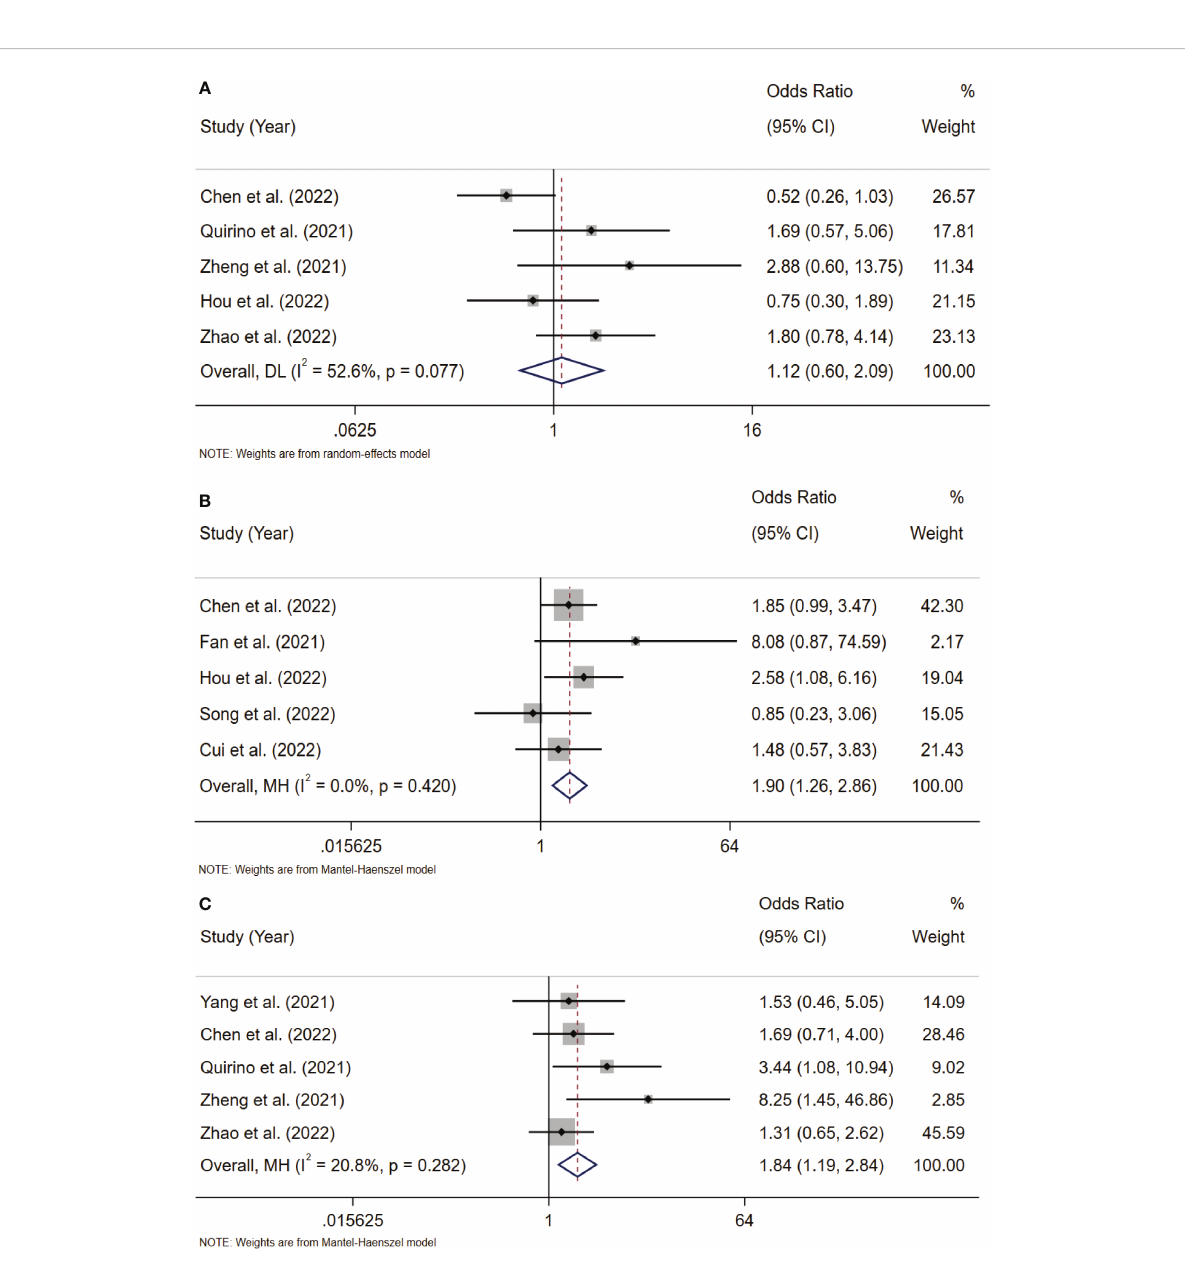
FIGURE 7 Forest plots of Siglec-15 expression and clinicopathological features in solid tumor. (A) LNM (Yes vs . No); (B) tumor size (>5cm vs .<5 cm); (C) TNM stage (III – IV vs . I – II). LNM, lymph node metastasis; TNM,